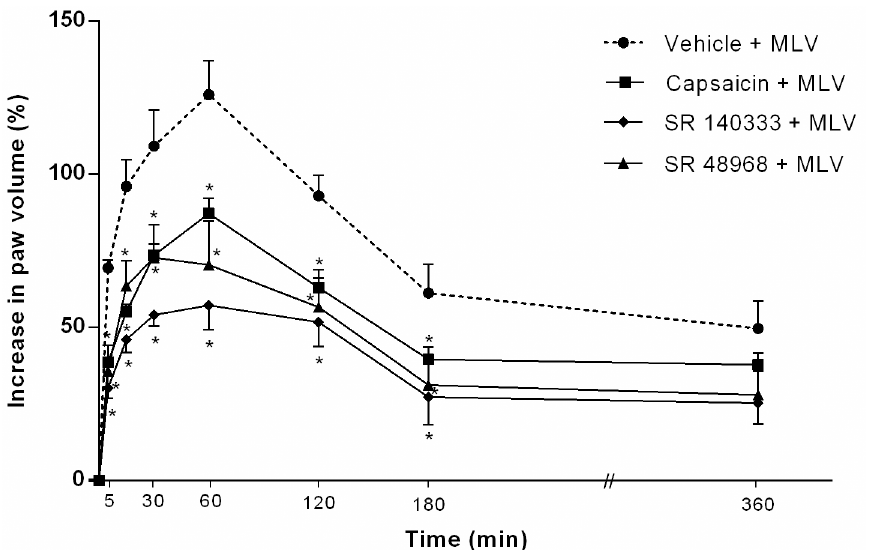
Fig 4. Effect of capsaicin and tachykinin NK 1 - and NK 2 -receptorantagonists (SR14033and SR 48968, respectively) on edema induced by Micrurus lemniscatus venom. Groups of animalswere treated with capsaicin(15, 30 and 50 mg/kg, s.c.) for 4 consecutivedays to depletesubstance P from sensitive primary afferent neuronsor NK 1 - or NK 2 receptor antagonists. Both SR 140333(1 nmol/paw) and SR 48968 (10 nmol/ paw) were co-injected i.pl. with MLV (5 μ g/paw).The increasein volume of each paw (edema) was measured using a plethysmometer. Results were calculatedas the difference betweenhind paws and are expressedas a % increasein paw volume. Values are the mean ± SEM of five animals. * p < 0.05 comparedwith control group.